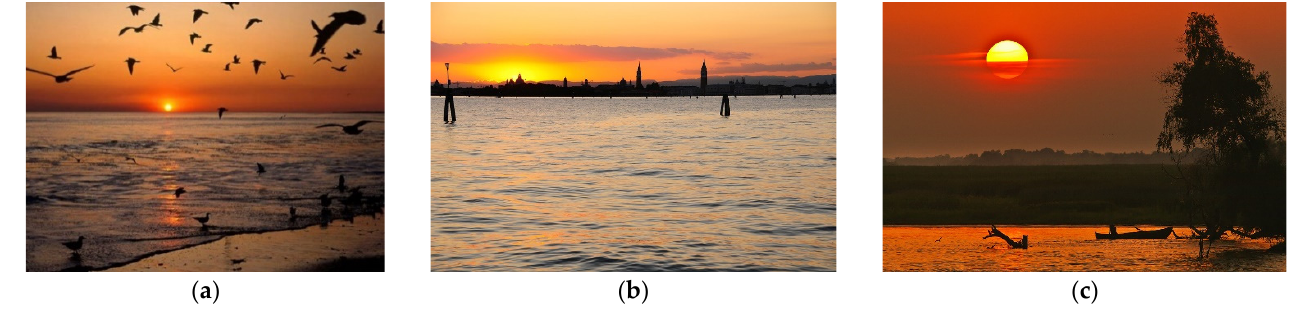
Figure 8. Sunset in some lagoons: ( a ) Bardawil, ( b ) Venice, ( c ) Razim-Sinoie. Source: Google Pho-